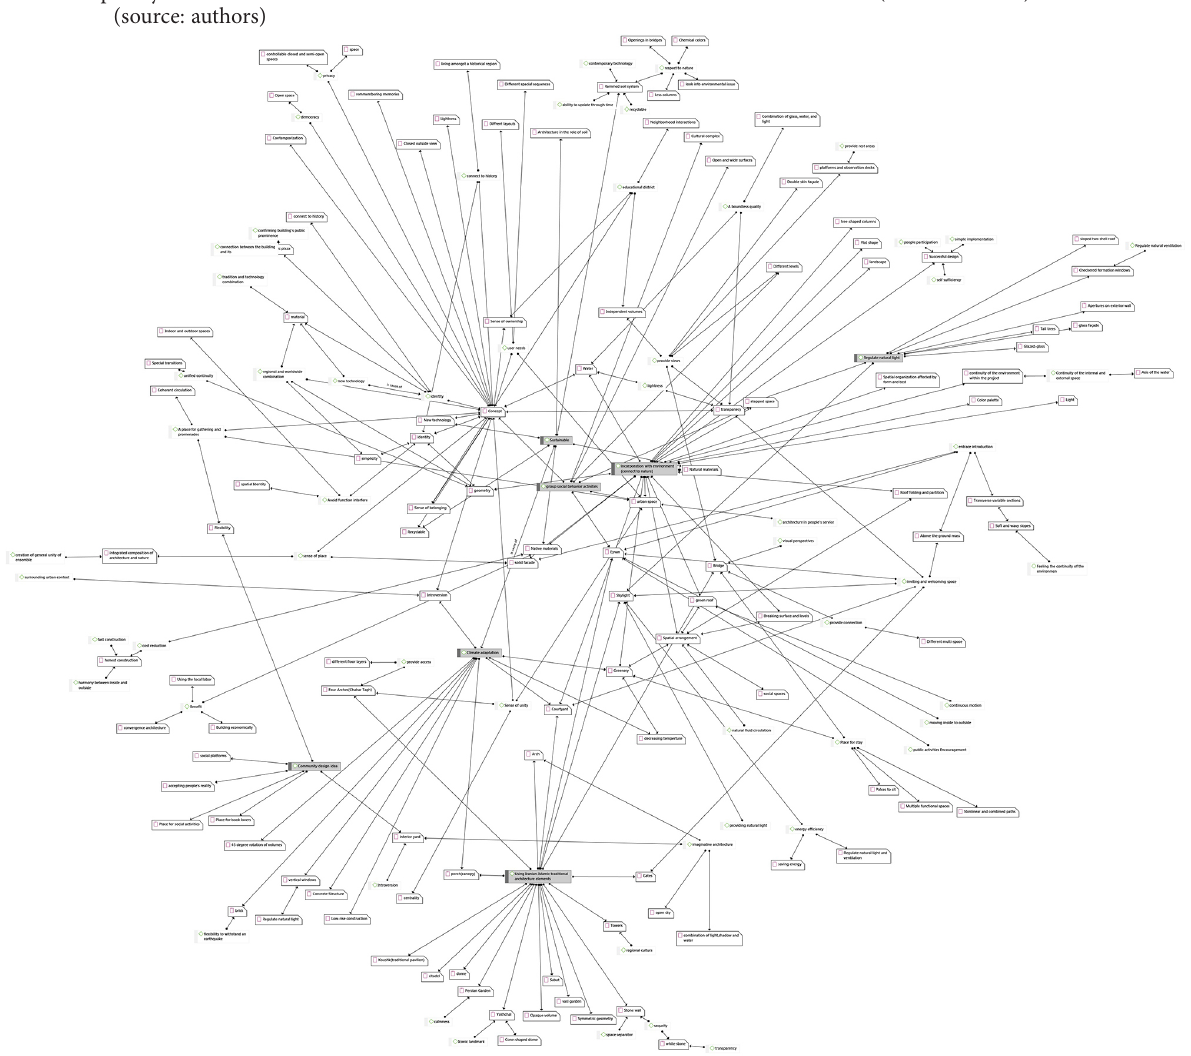
Figure 18. Analysis model of codes related to volumetric design indicators in contemporary Iranian architectural buildings based on data analysis, by ATLAS.ti software (source: